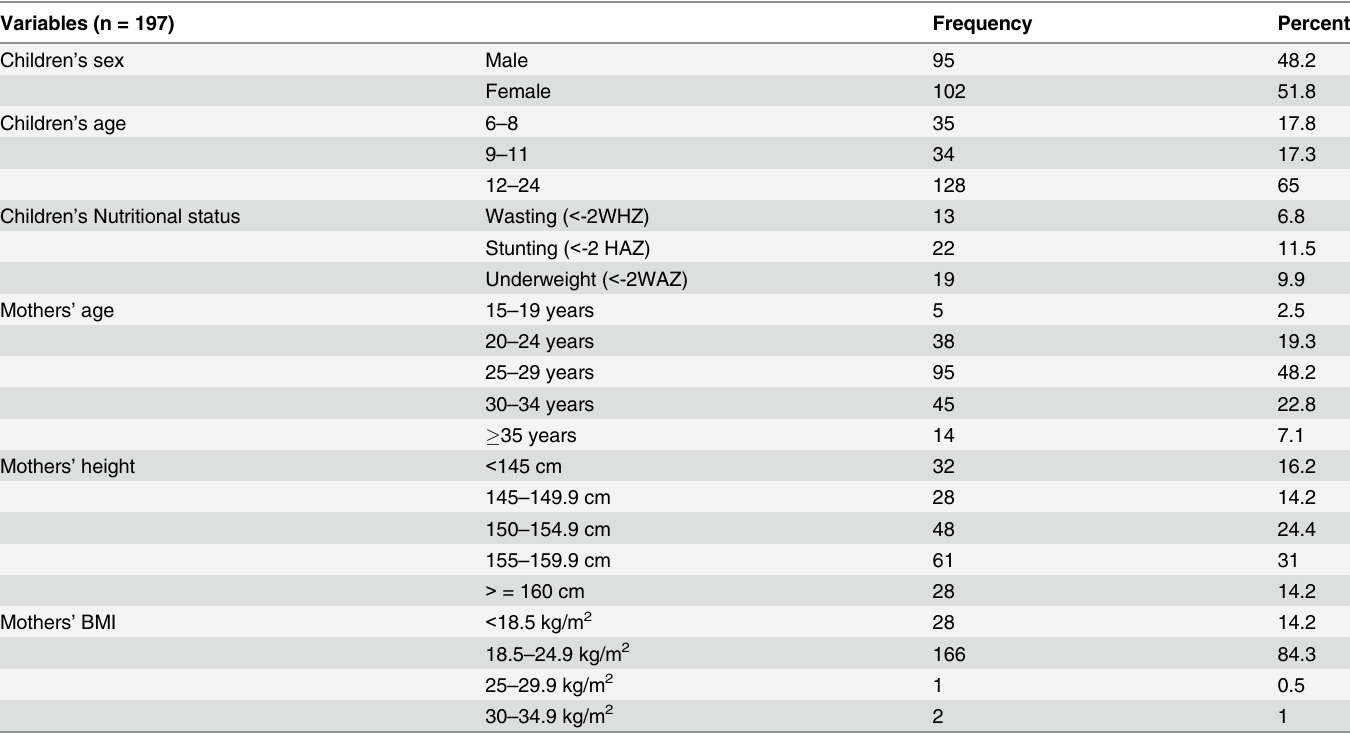
Table 2. Mothers' and children's anthropometry.